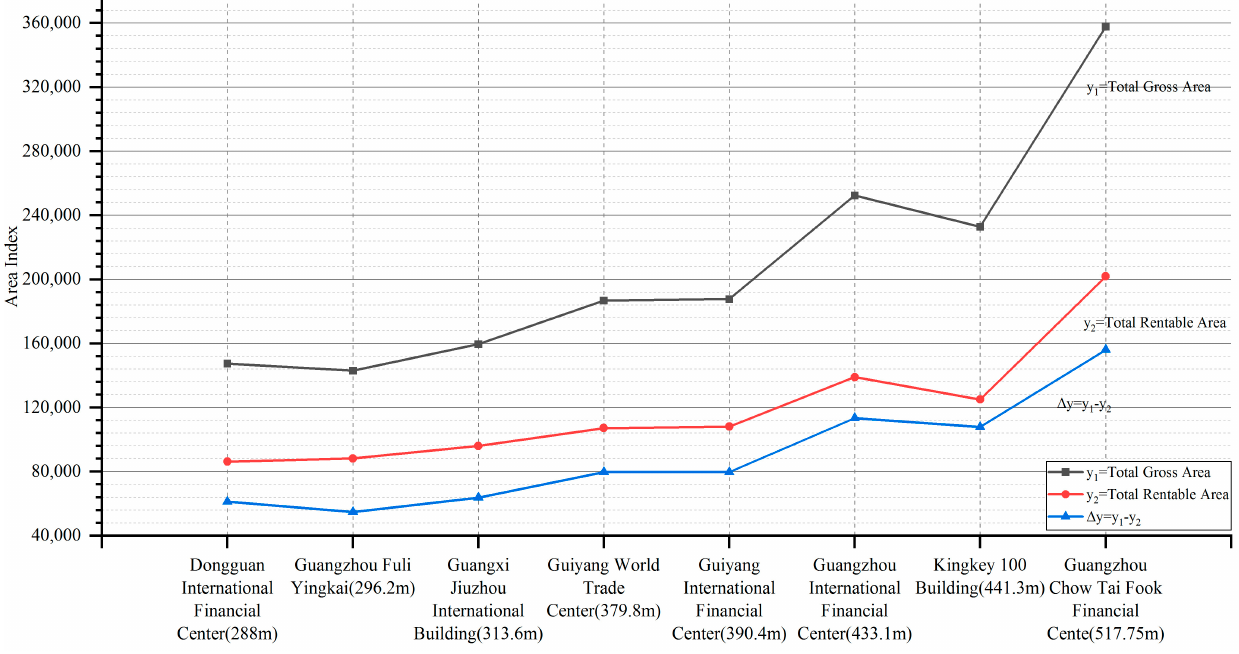
Figure 25. Comparison of building area and rentable area of the eight buildings.